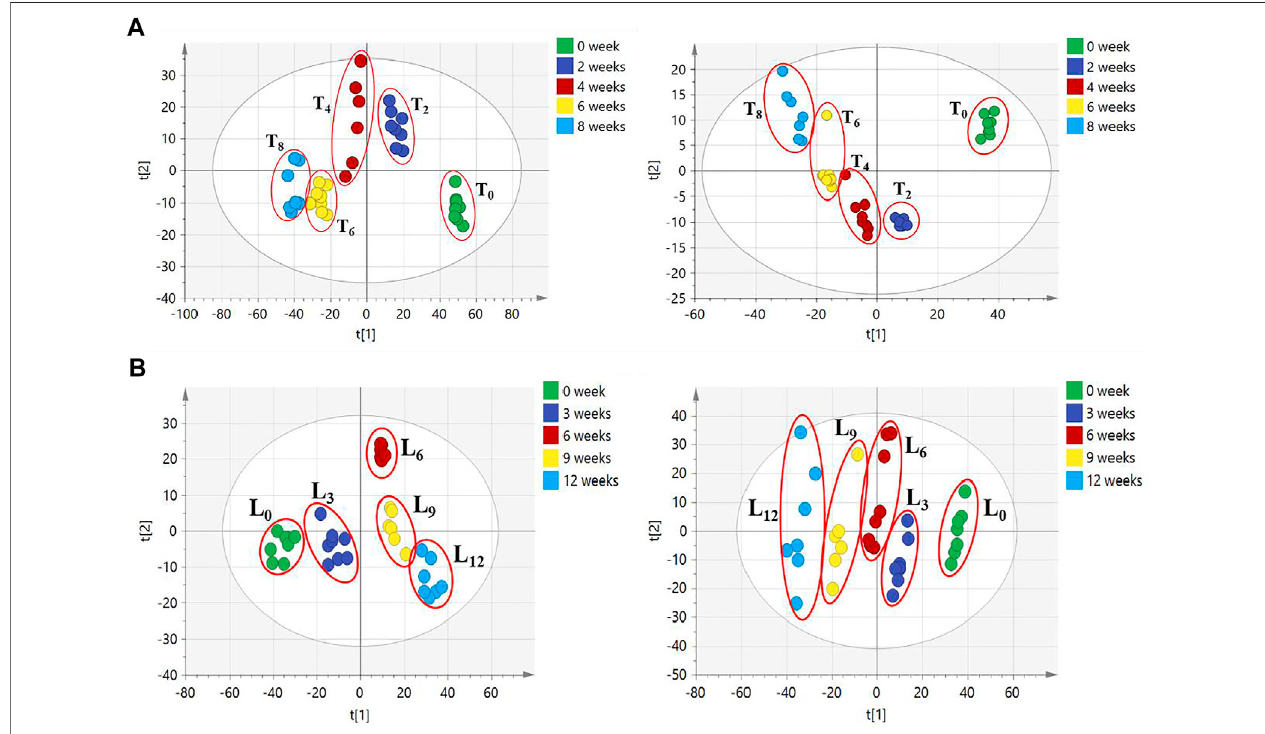
FIGURE 5 | Venn diagrams show the common compounds of (A) temperature-accelerated and light-accelerated groups and (B) accelerated tests and CHS-J samples produced in different production years.